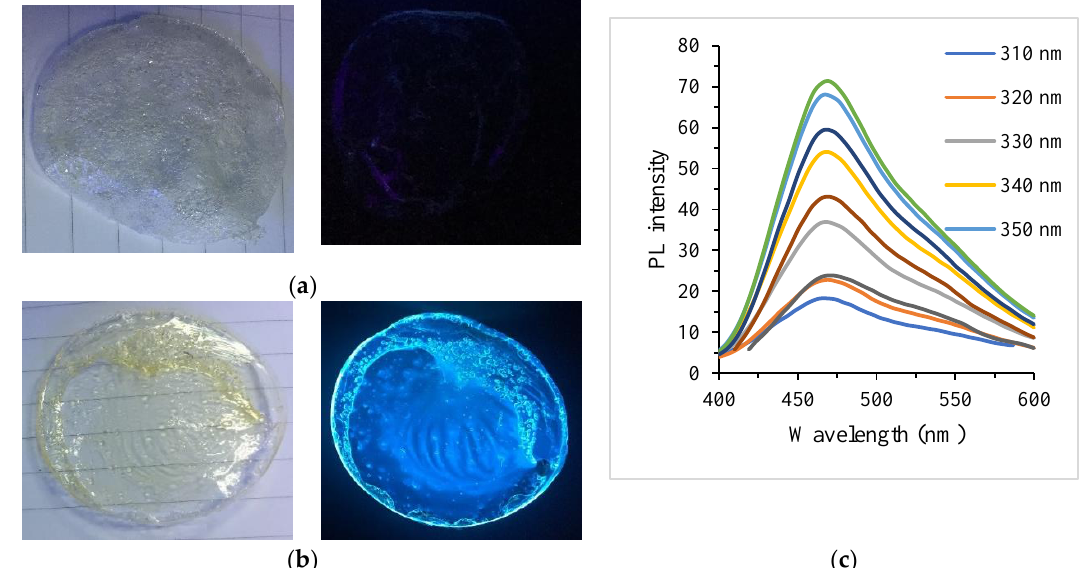
Figure 7. Photographs of poly (vinyl alcohol (PVA) film ( a ) before and ( b ) after encapsulating with N–CDs under ambient light (up) and UV light (down) and ( c ) PL spectra of PVA/N–CDs film at different excitation wavelengths (310–390 nm).